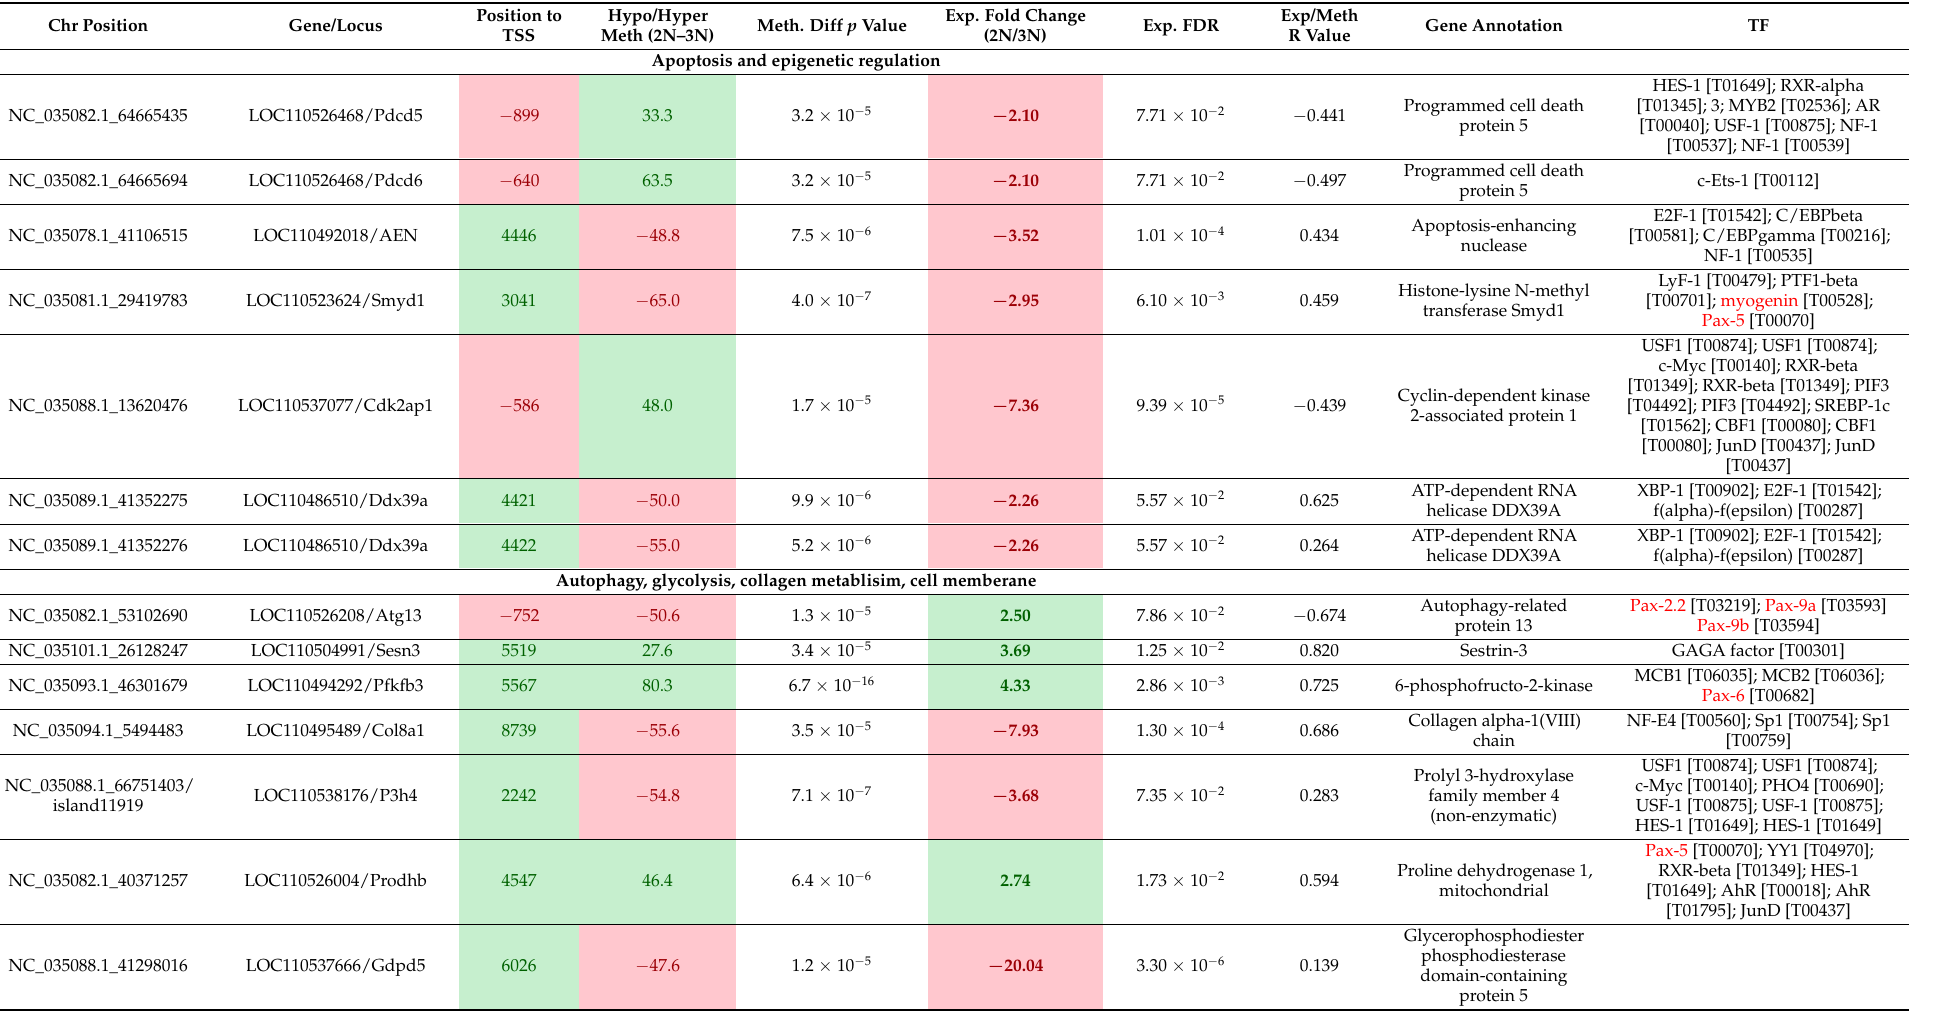
Table 2. DM CpGs and their associated differential gene expression in atrophied muscle of gravid/2N fish compared to sterile/3N fish. Highlighted cells in green and red indicates positive and negative changes. Highlighted TFs are the most common transcription